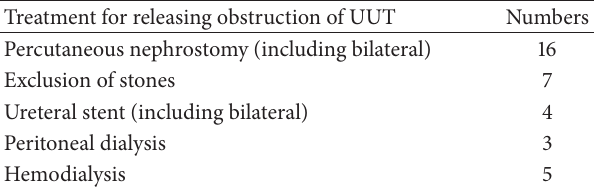
Table 2: The treatments for releasing UUT obstruction in 32 cases of postrenal failure due to ureteral stones associated with acute viral